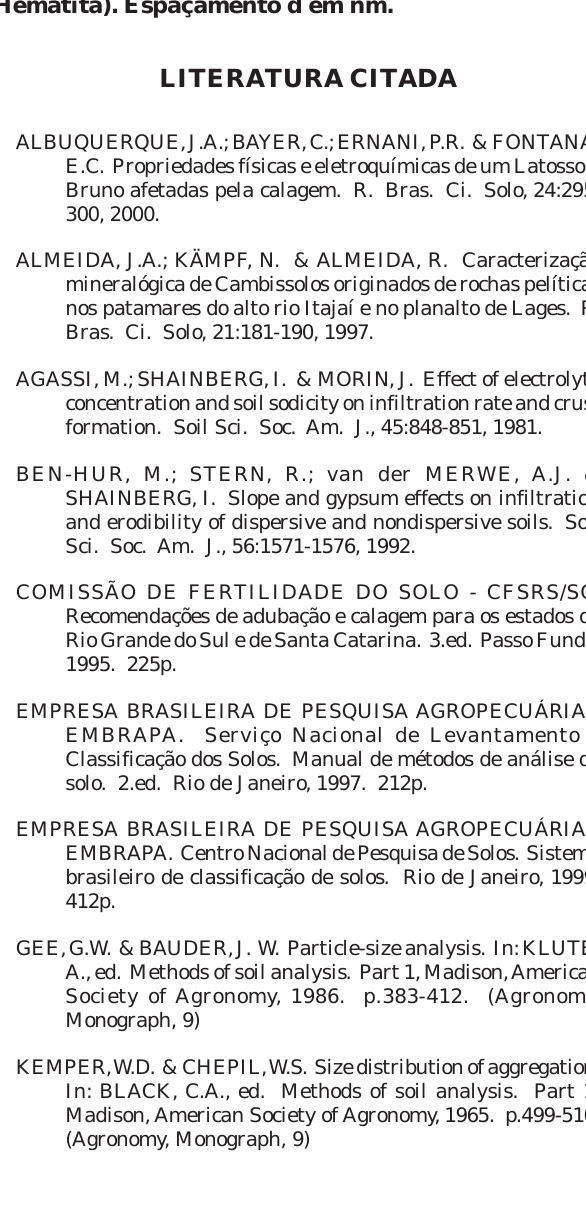
Figura 5. Difratogramas de raios-X da fração argila orientada e das frações silte (SI) e areia (AR) em pó do Latossolo Bruno distrófico. A fração argila foi saturada com magnésio (Mg), potássio a 25 °C (K- 25) e aquecida a 100 °C (K-100). 2:1HE = argilomineral do tipo 2:1; Ct = caulinita; Gb = gibbsita; Gt = goethita; Qt = quartzo; Il = Ilmenita; Hm = Hematita). Espaçamento d em